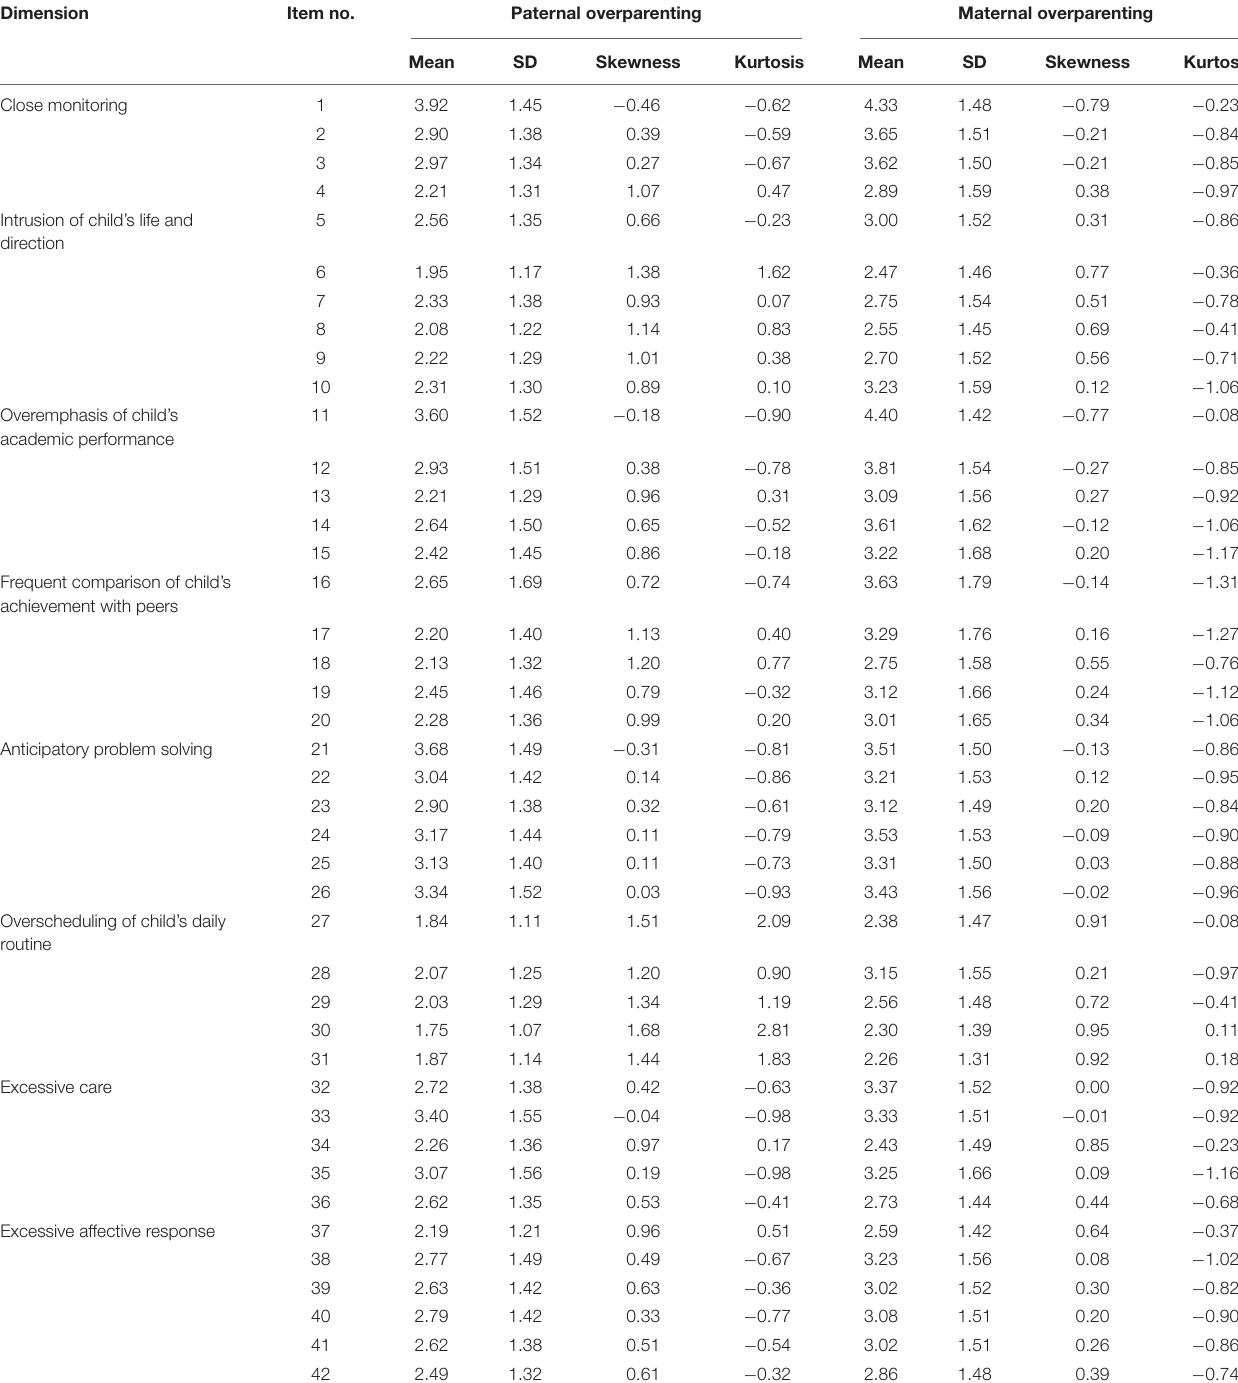
TABLE 2 | Descriptive statistics of Chinese paternal/maternal overparenting scales. Dimension Item no. Paternal